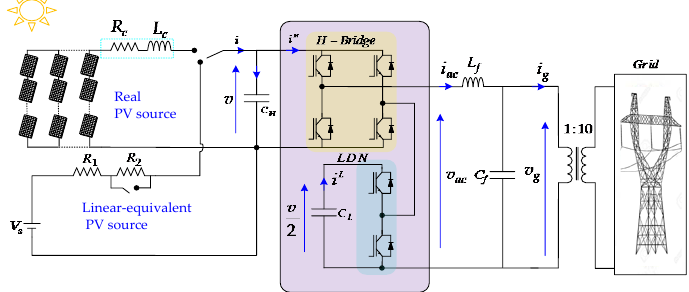
Figure 15. Circuit scheme of the experimental setup including the whole PV generation system.